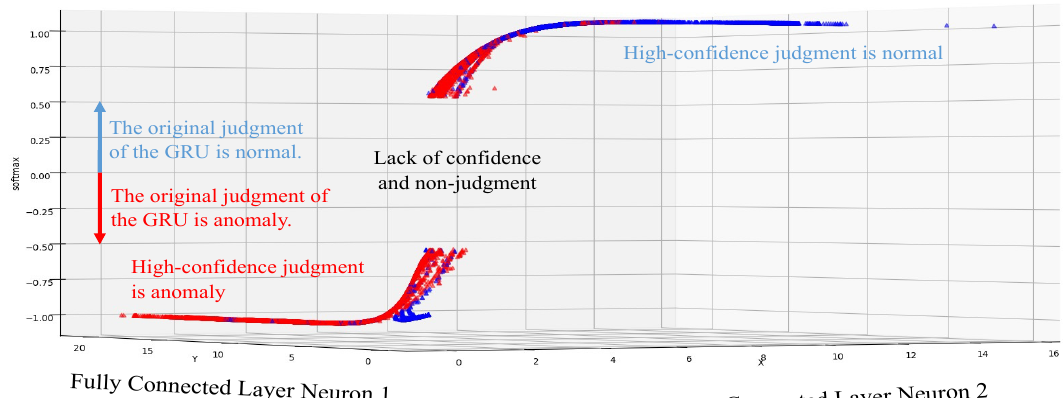
The red samples and the blue samples are the actual attacks and the actual normal sample, respectively. The x and y axes are the output of two hidden layer neurons, and the z-axis is the Softmax confidence score, in which the value is between 1 and − 1. The Softmax confidence score greater than 0 means that the original GRU_3 model’s judgment is normal, and the Softmax confidence score less than 0 means the judgment is abnormal. It can be found that there are many judging errors (gray blocks) in the GRU as a whole. The overall accuracy of the GRU_3 model is 78.85%, but when the confidence score is close to 1 and − 1 (blue block and red block), the judging result is obviously much better. Therefore, according to the confidence threshold we set, GRU will output the samples with high confidence score, and the remaining samples with insufficient confidence will be handed over to DAE for processing. Through the data visualization in Figure 10, it can be understood that the overall under-performing model may still perform well in the judging accuracy of the high confidence interval.